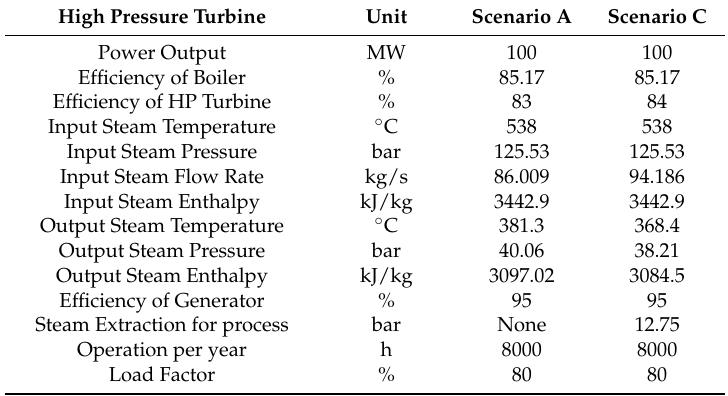
Table 1. Operating conditions for power plants fired by off-gases under scenario A vs. scenario C (generation of 100 MW power and 45 tons of steam